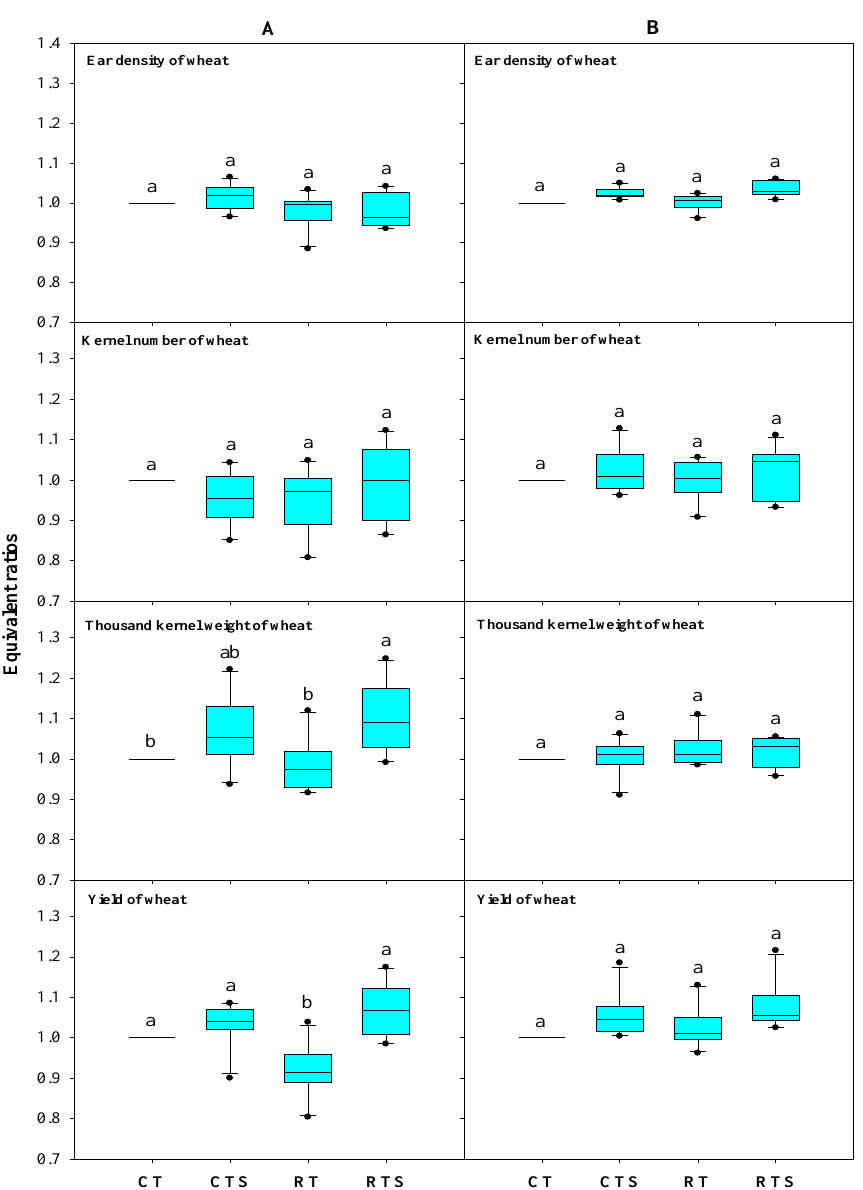
Figure 4. Box plots of equivalent ratios of the wheat yield and yield components under tillage and straw returning practices at the Tai’an ( A ) and Longkou ( B ) experimental sites. The horizontal line inside the boxes denotes the median value. The error bars show the upper/lower quartiles (1.5 interquartile distance). The line extending vertically from the box represents the variability beyond the range of the upper and lower quartiles, and the values represent the 10th and 90th percentiles, respectively; the points that lie outside of this range are shown as solid circles. CT: conventional tillage without straw returning; CTS: conventional tillage with straw returning; RT: rotary tillage indicate significant differences between different treatments ( p < 0.05 ; Duncan’s test).